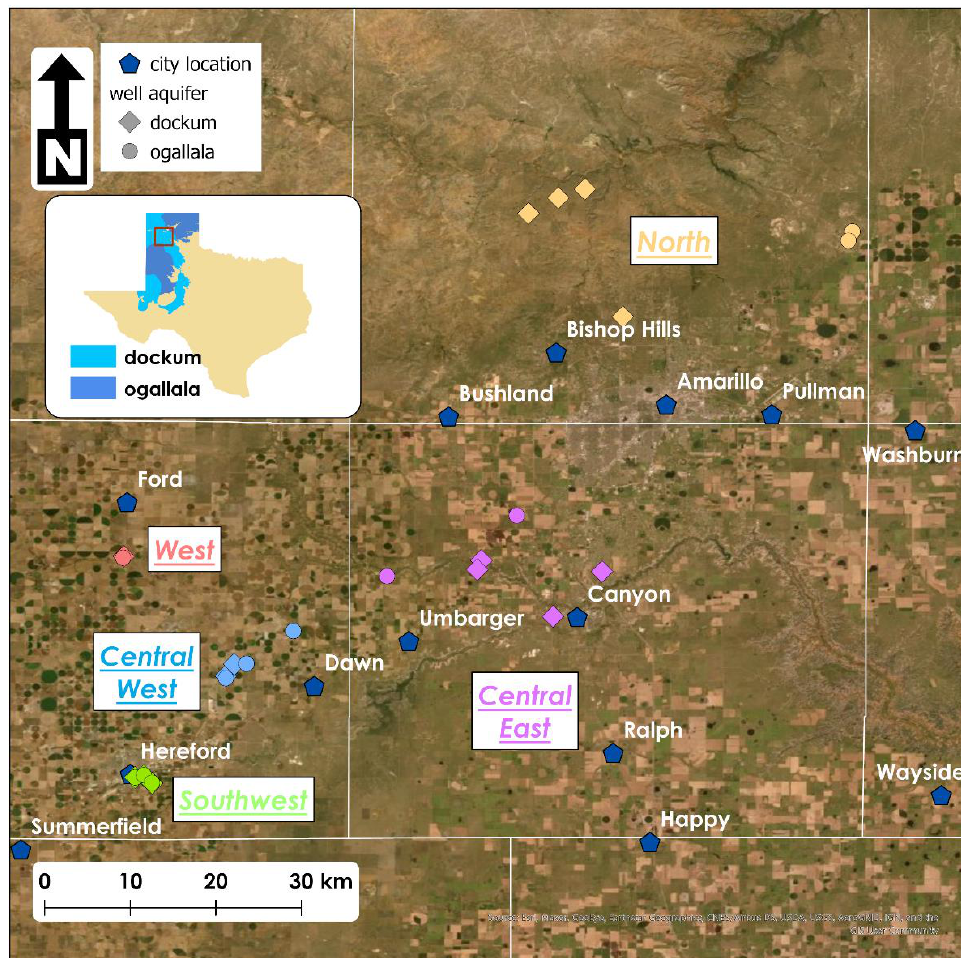
Figure 1. Study location with sampling sites in the Texas Panhandle. Colors indicate well analysis groups (West—pink, Central West—blue, Southwest—green, Central East—purple, North— tan/orange), locations which are geographically clustered. Shapes indicate the aquifer from which wells pull water either Dockum (diamonds) or Ogallala (circles).